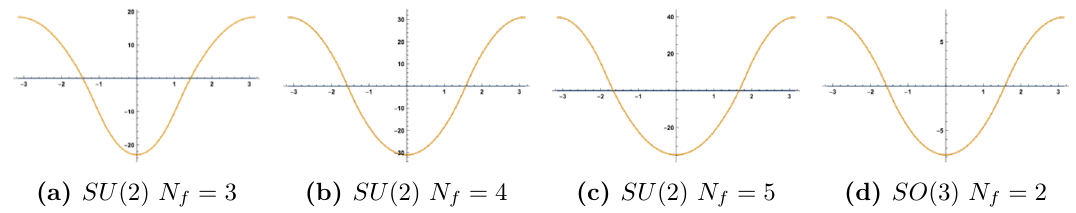
Figure 1. ( Re F , Im F ) | ∆= − iπ of rank-1 SQCDs. The blue/orange line is Re F /Im F